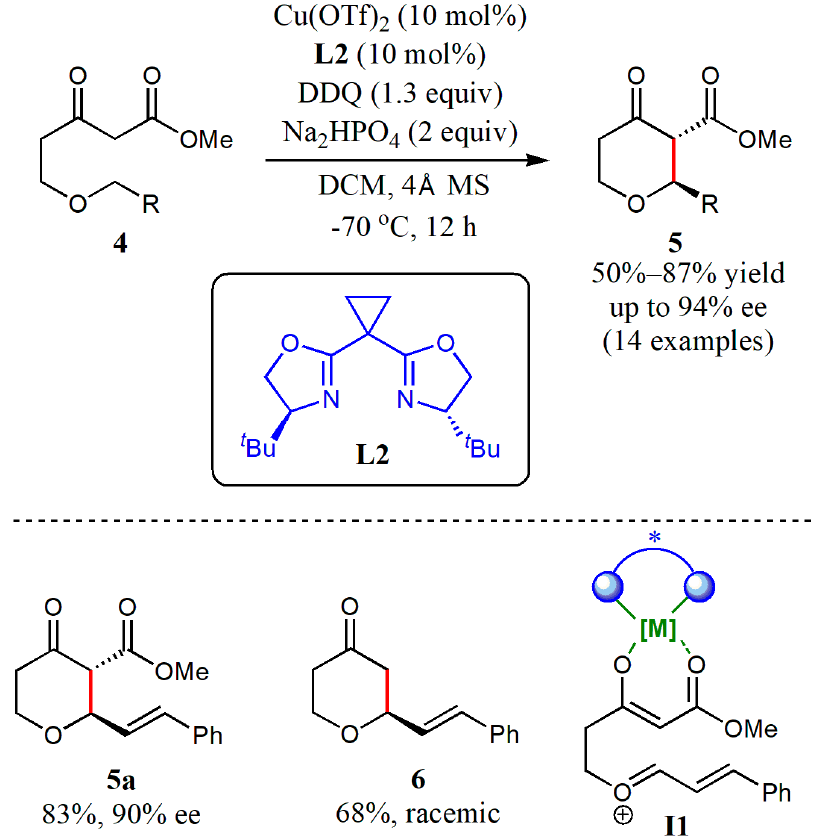
Figure 3. Enantioselective CDC of β -ketoesters for the synthesis of tetrahydropyrans.